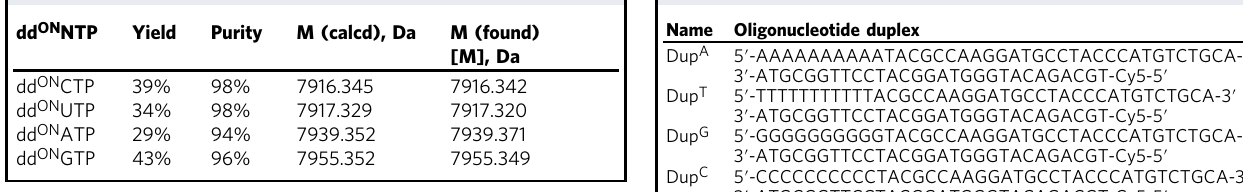
Table 2 Oligonucleotide duplexes used for dd ON NTP incorporation